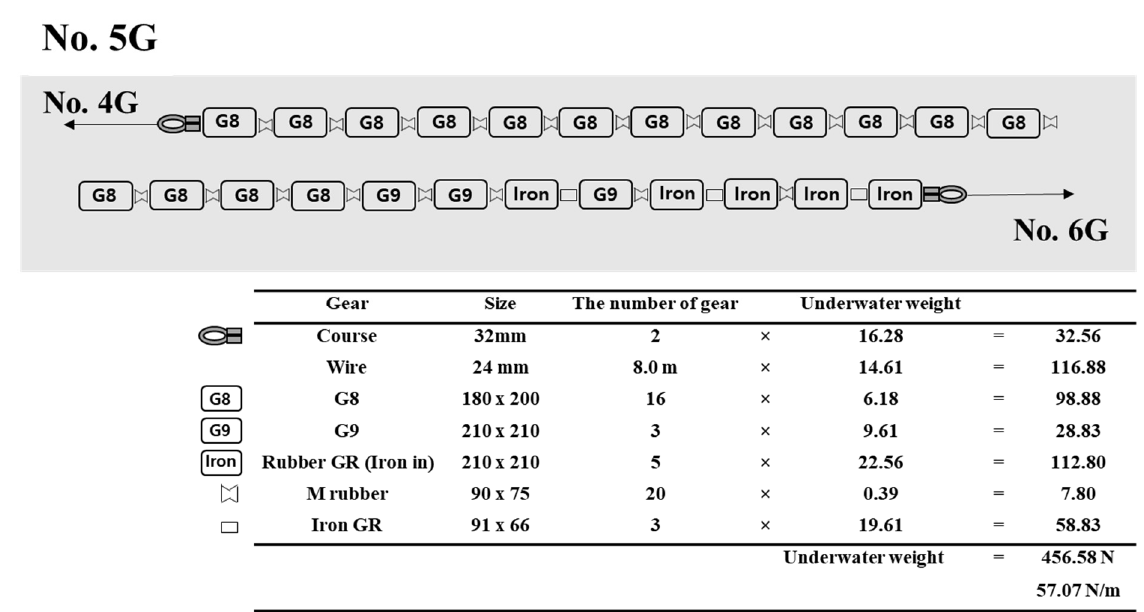
Figure 13. The arrangement of ground gear in redesigned by rearrangement of ground rope.